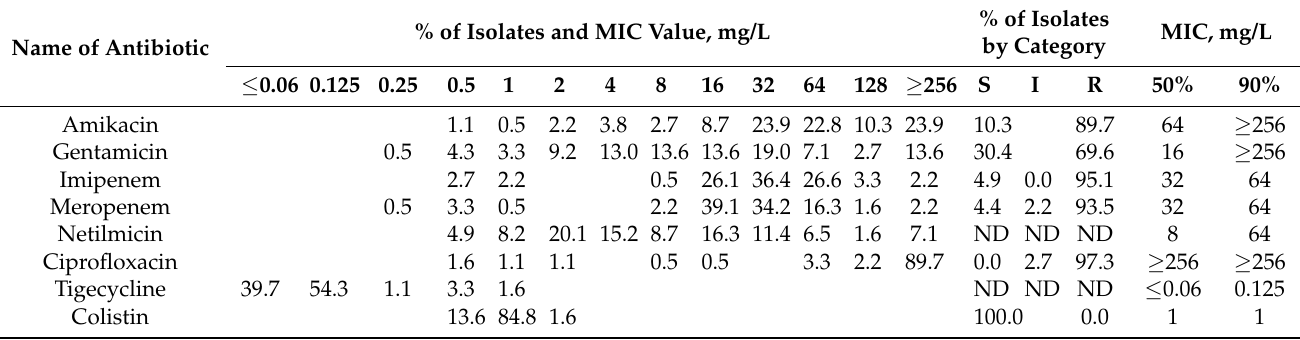
Table 2. Antibiotic sensitivity of A. baumannii isolates ( n = 184) producing acquired OXA-carbapenemases.